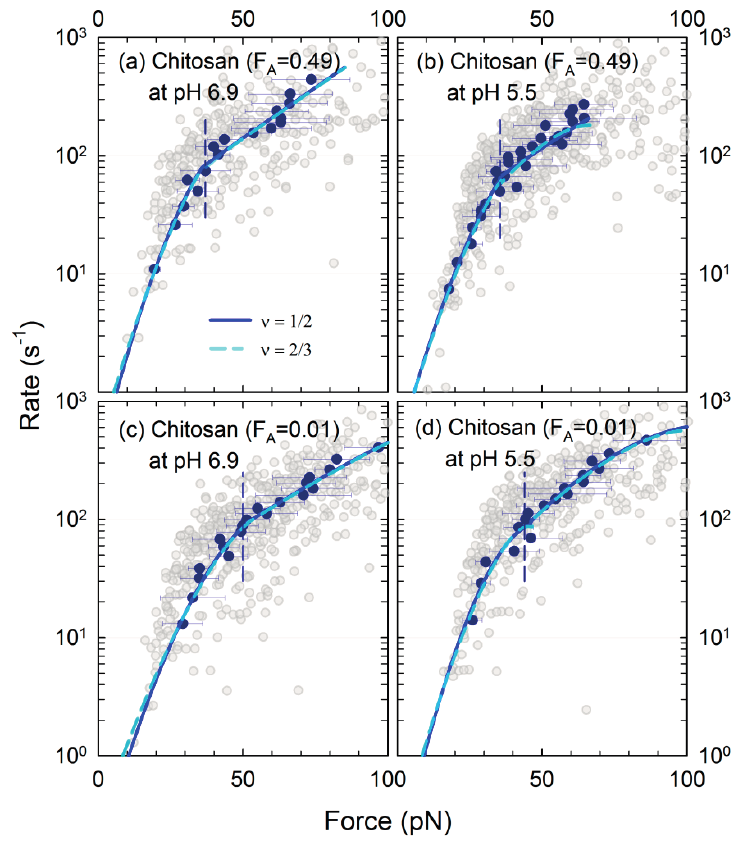
Figure 6. The lifetime of the chitosan–mucin interactions versus force for chitosan with F A = 0.01 and 0.49, at pH 5.5 and 6.9 in the aqueous buffer (buffer conditions as in Figure 5). The data is presented as dissociation rate versus magnitude of force at dissociation for individual forced dissociation events (transparent symbols) and mean dissociation rate ± standard deviation versus mean dissociation force (blue symbols) in the sub–distributions, respectively. The continuous lines depict the fit to theory for dissociation rate versus rupture force (Equation (2)) for the energy barriers with ν = 1/2 and ν = 2/3. The vertical dashed lines depict the border between the region where the inner and outer barrier are limiting the